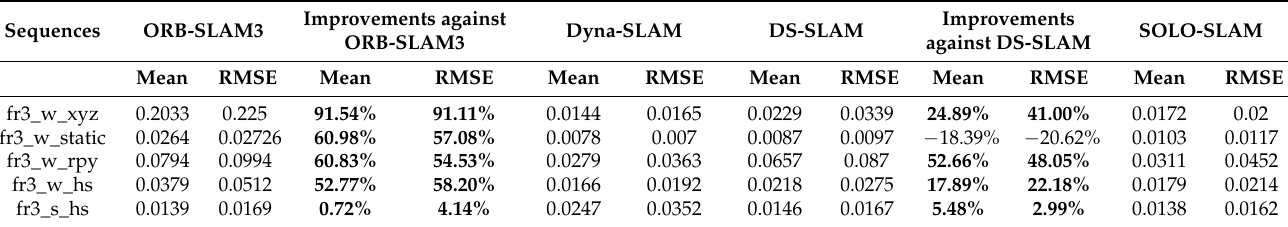
Table 3. Experimental results of translational relative trajectory error.